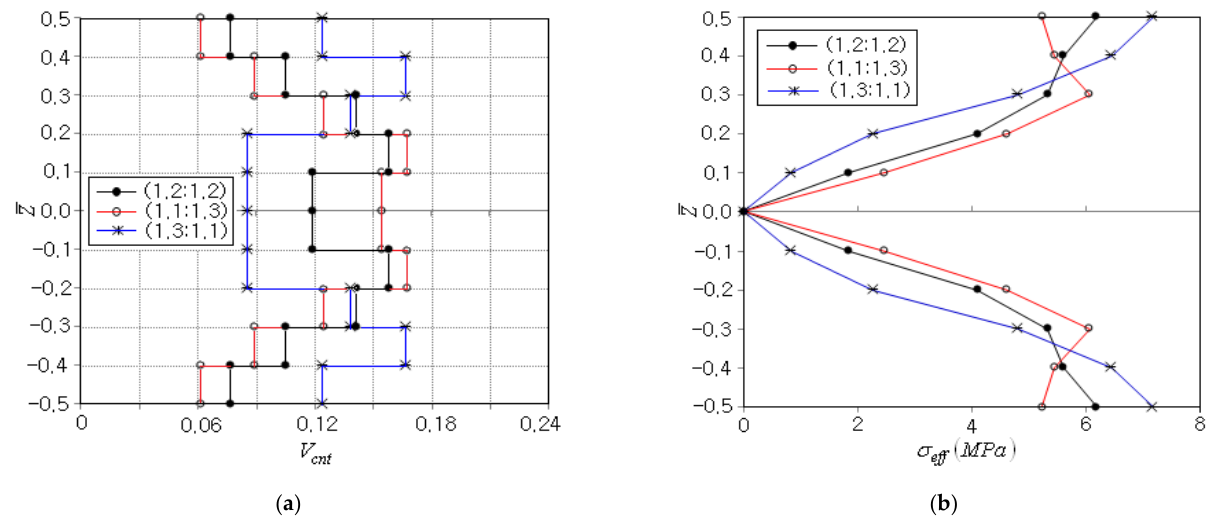
Figure 11. Trade-off between σ max and w max : ( a ) optimal CNT distribution, ( b ) thickness-wise effective stress distribution.